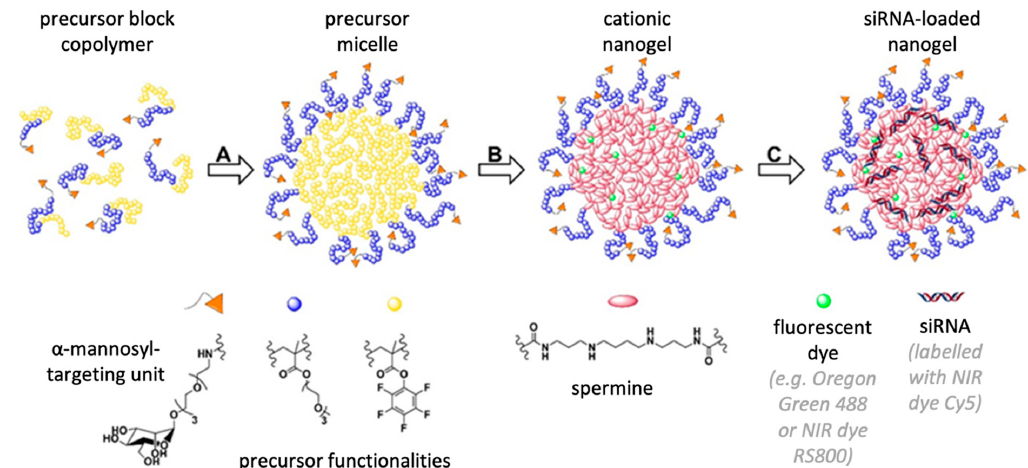
Figure 1. Preparation scheme of α -mannosyl-functionalized cationic nanohydrogels (ManNP): RAFT polymerization with an α -mannosyl-functionalized chain transfer agent yielded amphiphilic reactive ester block copolymers. ( A ) In aprotic solvents, co-block polymers spontaneously assemble into micellar structures with reactive ester cores. ( B ) Cross-linking of these precursor micelles is obtained by spermine, a bifunctional oligoamine, yielding ManNP with a cationic core. Fluorescent